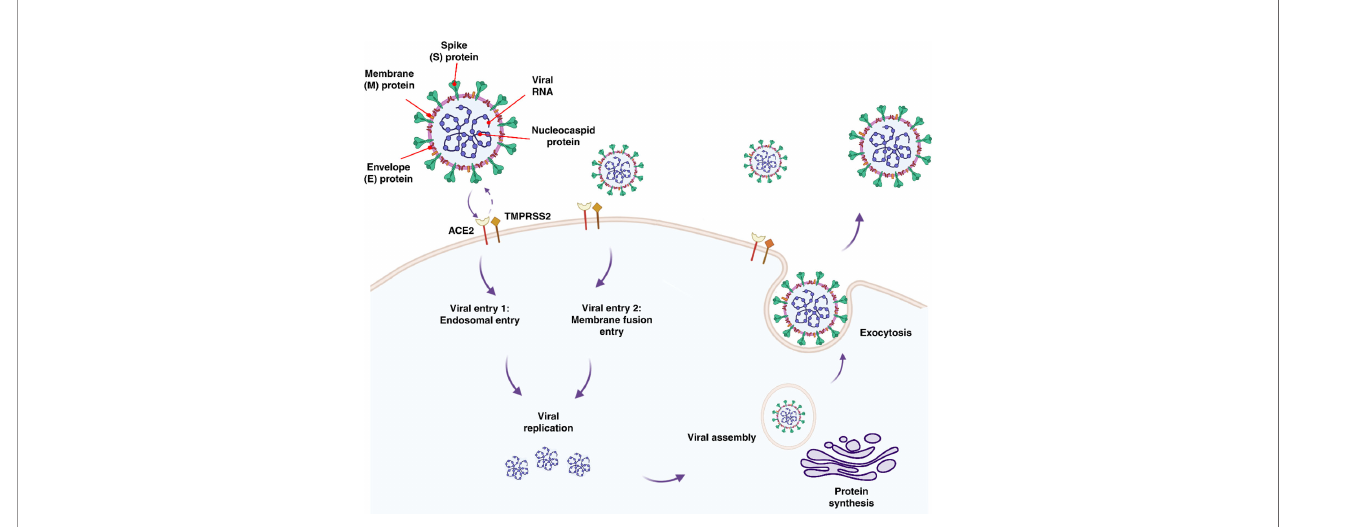
FIGURE 1 | Features, entry methods, and replication of